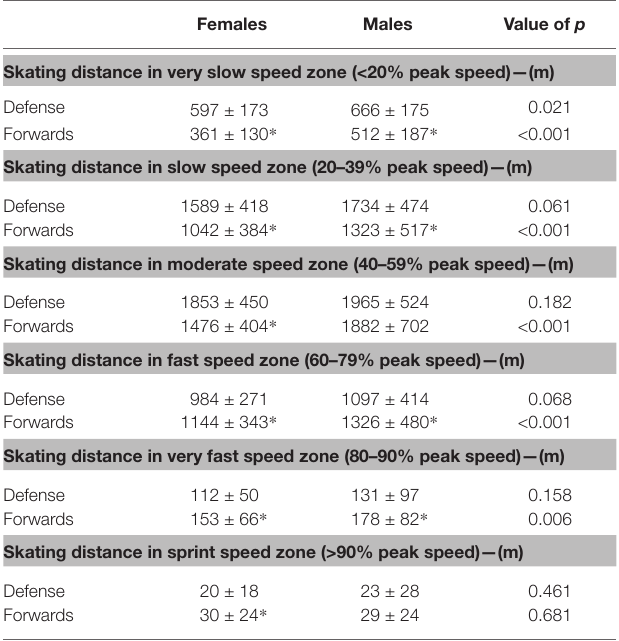
TABLE 3 | Comparison of local positioning system measured relative skating distances between females and males during regular season ice hockey games. Females Males Value of p